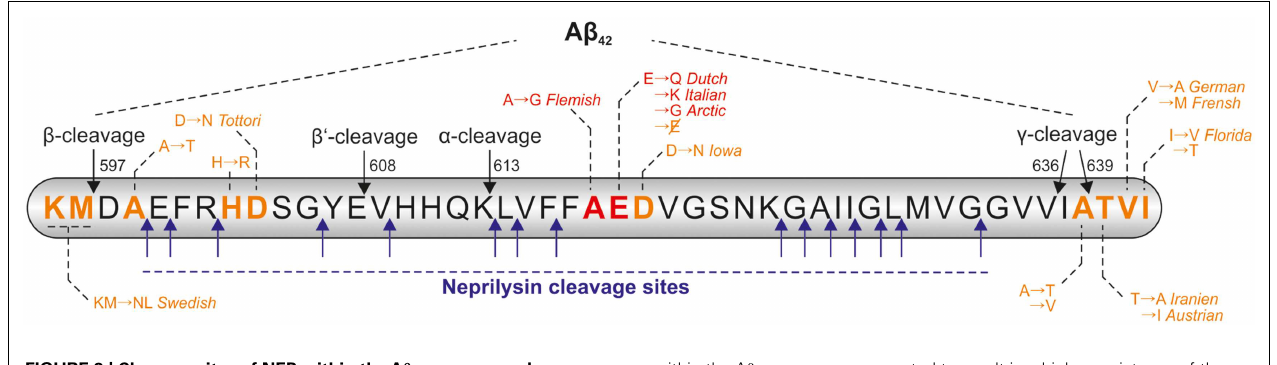
FIGURE 2 | Cleavage sites of NEP within theA β -sequence and positions of FAD mutations .Within the A β sequence there are several cleavage sites for neprilysin (NEP), the cleavage positions of α -, β -, and γ -secretase are also indicated. Some of the pathological point mutations